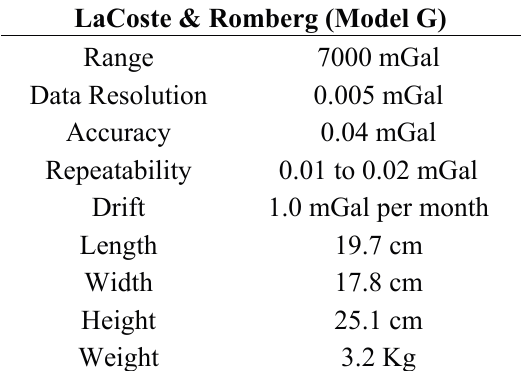
Table 6. Specifications of the LaCoste & Romberg gravimeter, model